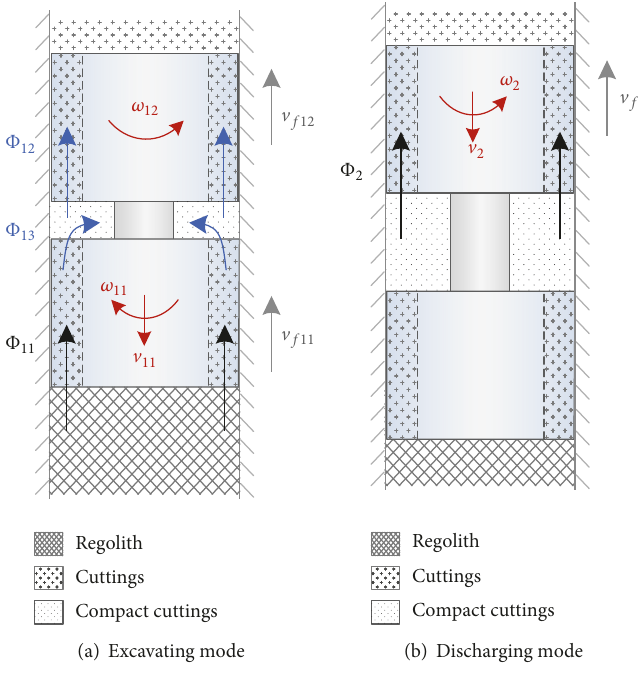
Figure 4: IBR working mode.